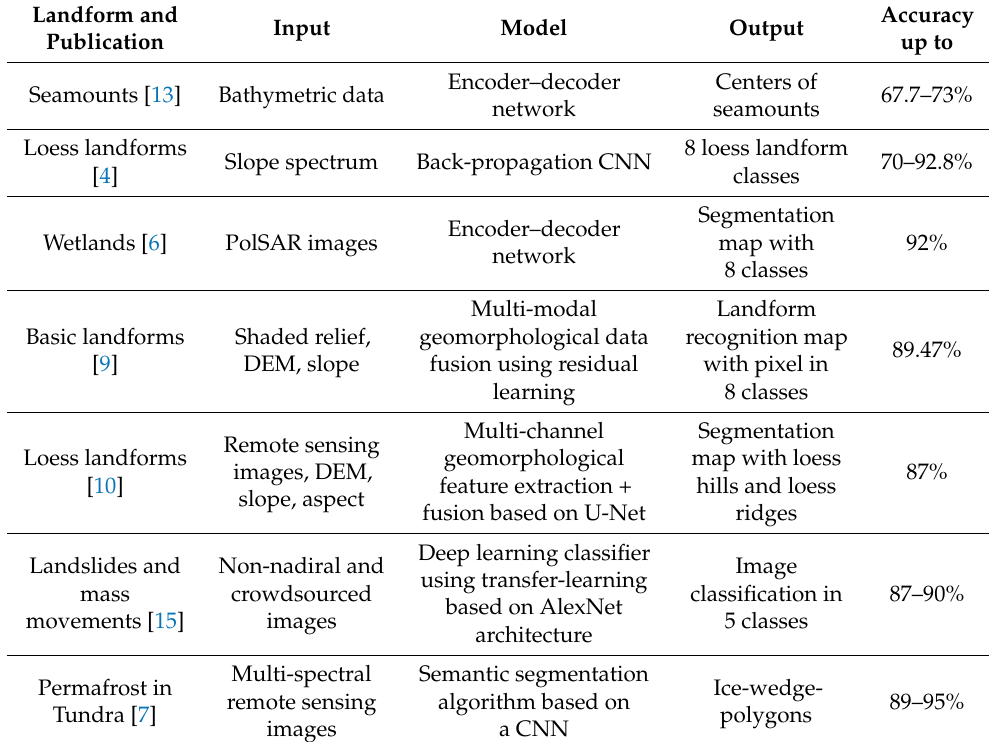
Table 1. Examples of existing machine learning segmentation algorithms assembled by